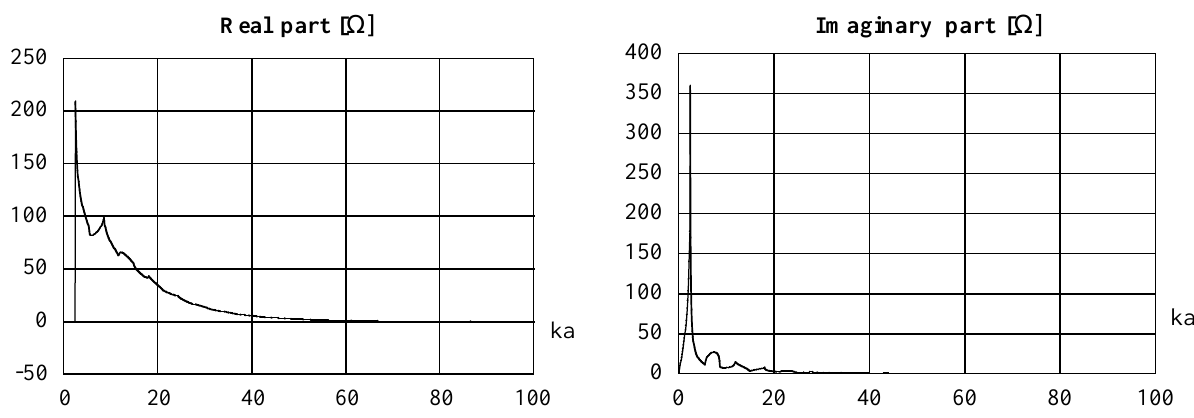
FIG. 14. Real and imaginary parts of the longitudinal coupling impedance in the case (cid:119) (cid:173) (cid:50) (cid:121) (cid:53) and bg (cid:173) (cid:49)(cid:48) .